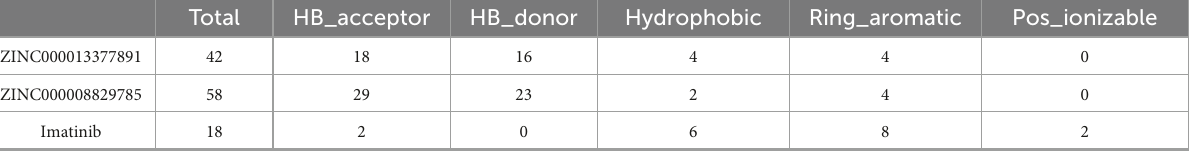
TABLE 7 The analysis of feature